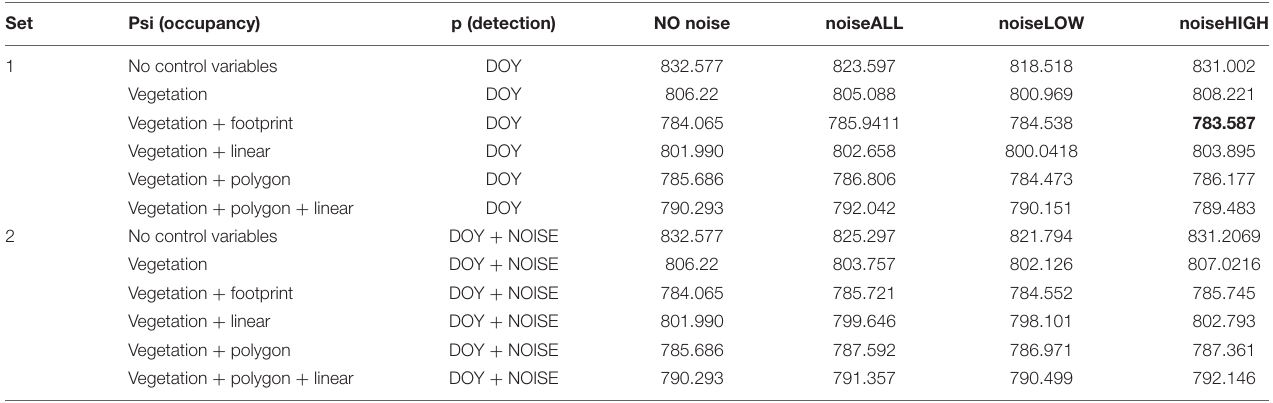
TABLE 5 | Occupancy and detection probability models (AIC values) explaining Lincoln’s Sparrow